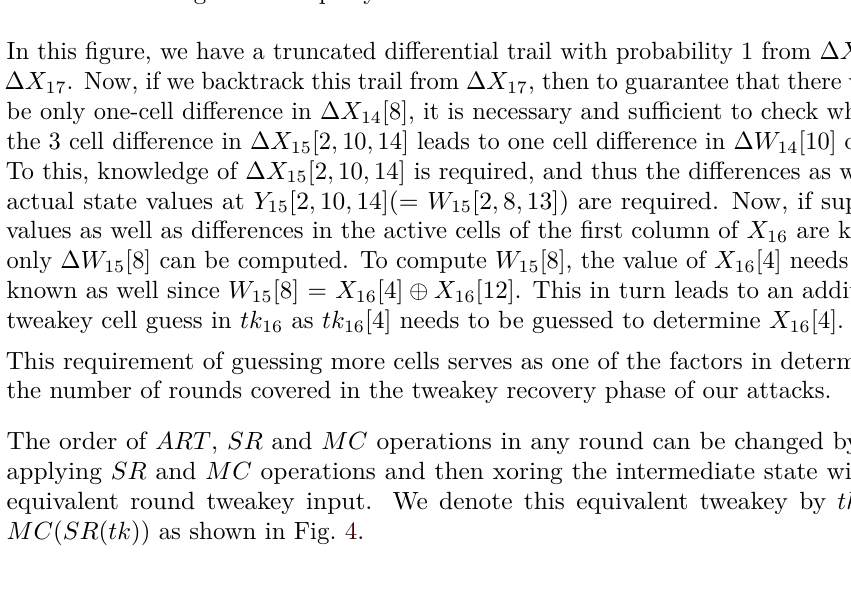
Figure 3: Property of MixColumns of